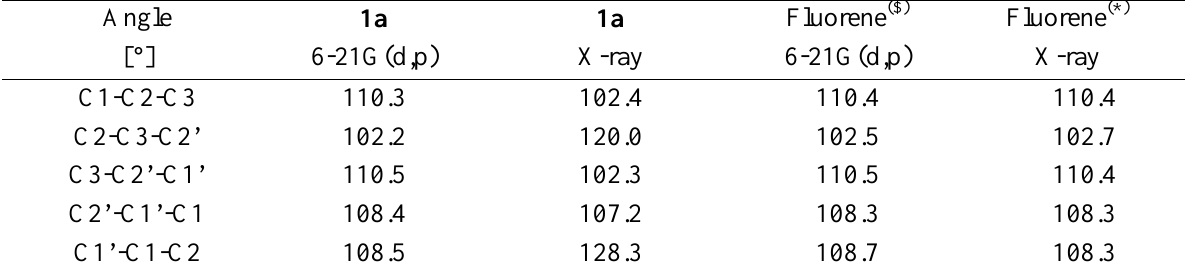
Table 1. Bond angles of the 5-member ring of fluorene in 1a fluorene alone [17] from the X-ray data and after full geometry